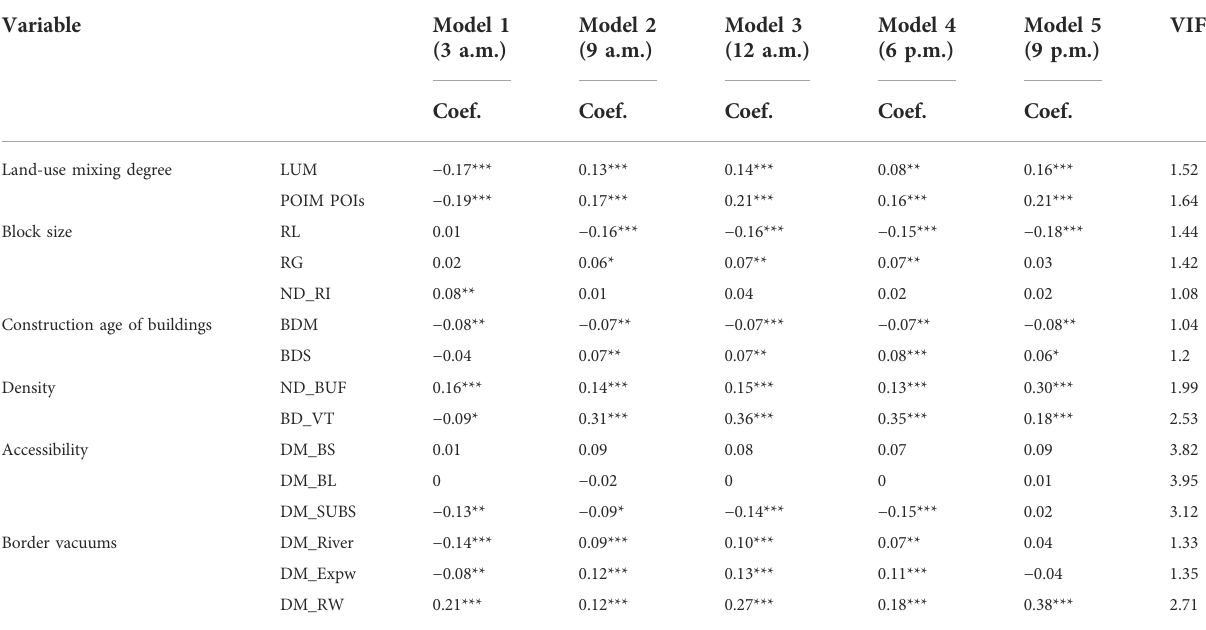
TABLE 2 Analysis results of OLS.